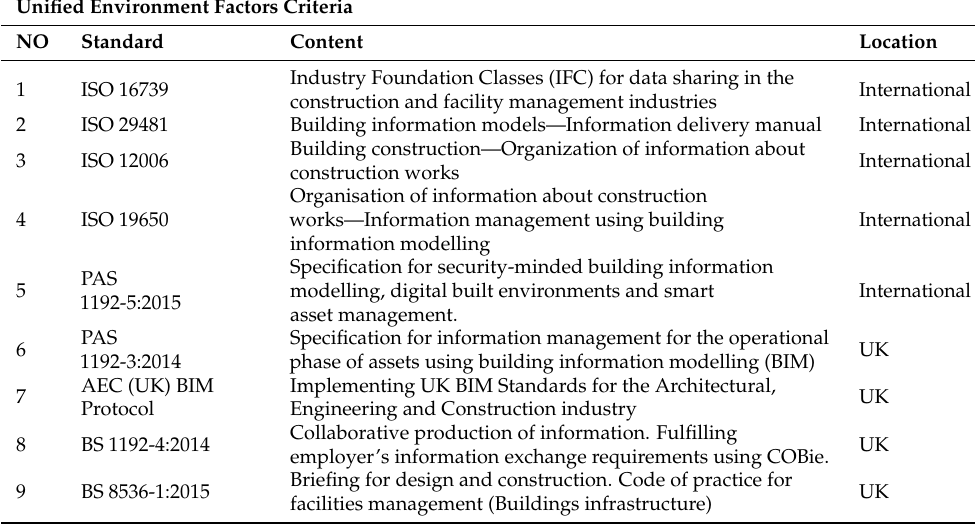
Table 2. Unified environment factor criteria. Unified Environment Factors